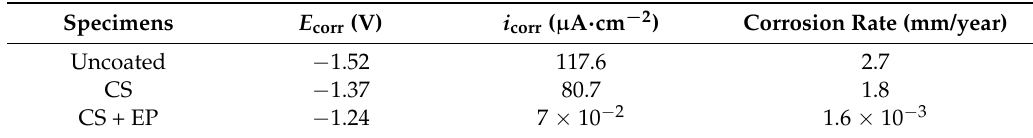
Table 2. Tafel fitting results for the uncoated, cold spray (CS) AA7075 coated and CS + EP coated AZ31B alloy